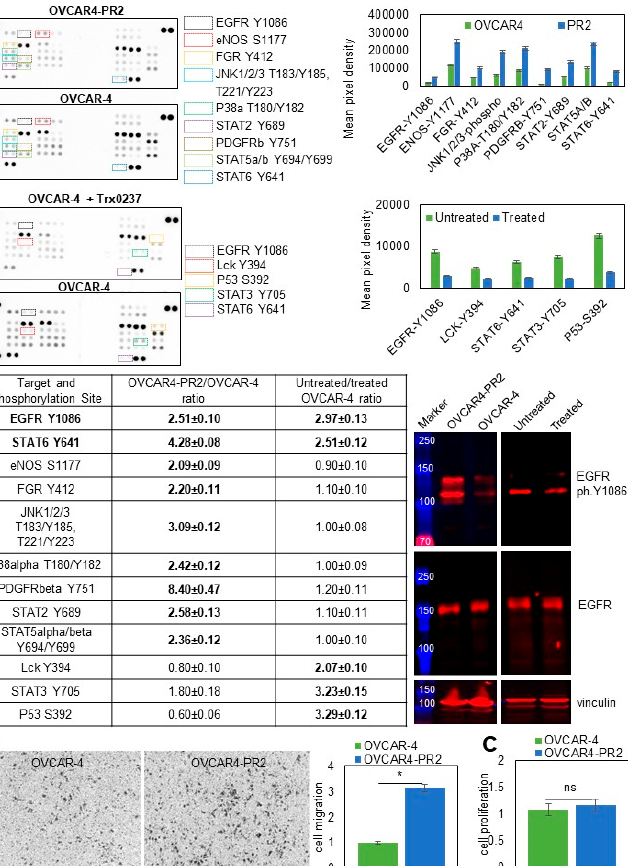
Figure 7. Paclitaxel-resistant phenotype is associated with changes in kinase activation that are partially reversed by the treatment with TRx0237. ( A ) Human phospho-kinase antibody array was used to determine relative levels of phosphorylation in 37 kinases and 2 related proteins in OVCAR-4 and OVCAR4-PR2, as well as OVCAR-4 treated with 6.7 µ M TRx0237 for 72 h and untreated OVCAR-4. Mean pixel density was measured by digital densitometry and Azure Biosystems software and plotted on the graphs. Mean pixel density in OVCAR4-PR2 was divided by that in OVCAR-4, and mean pixel density in OVCAR4 was divided by that in OVCAR-4 treated with TRx0237. Ratios > 2 were considered biologically significant and are shown in Table 1. Expression of phosphoY1086-EGFR (1:5000 dilution) and EGFR (1:200 dilution) was examined with Western blot. The uncropped blots are shown in File S1. ( B ) 10 5 cells were seeded atop Transwell inserts with 8-micron pores that were coated with collagen type I on the bottom and allowed to migrate for 9 h. Non-migrated cells were removed; migrated cells were fixed, stained, imaged with Zeiss Axiovert software, counted, plotted, and statistically analyzed with Student’s t -test. * p < 0.05. ( C ) Cell proliferation was measured using the WST-1 assay. OD440 values for the parental OVCAR-4 were arbitrarily set at 1, and the corresponding values for OVCAR4-PR2 were calculated accordingly, plotted, and statistically analyzed with Mann–Whitney U